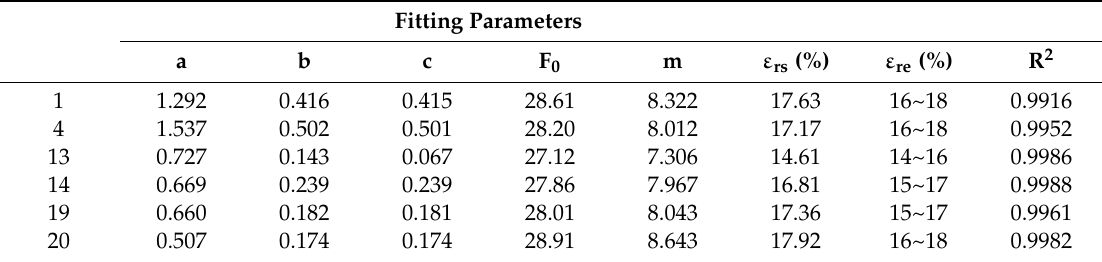
Table 4. Computational parameters of the statistical damage (SD)